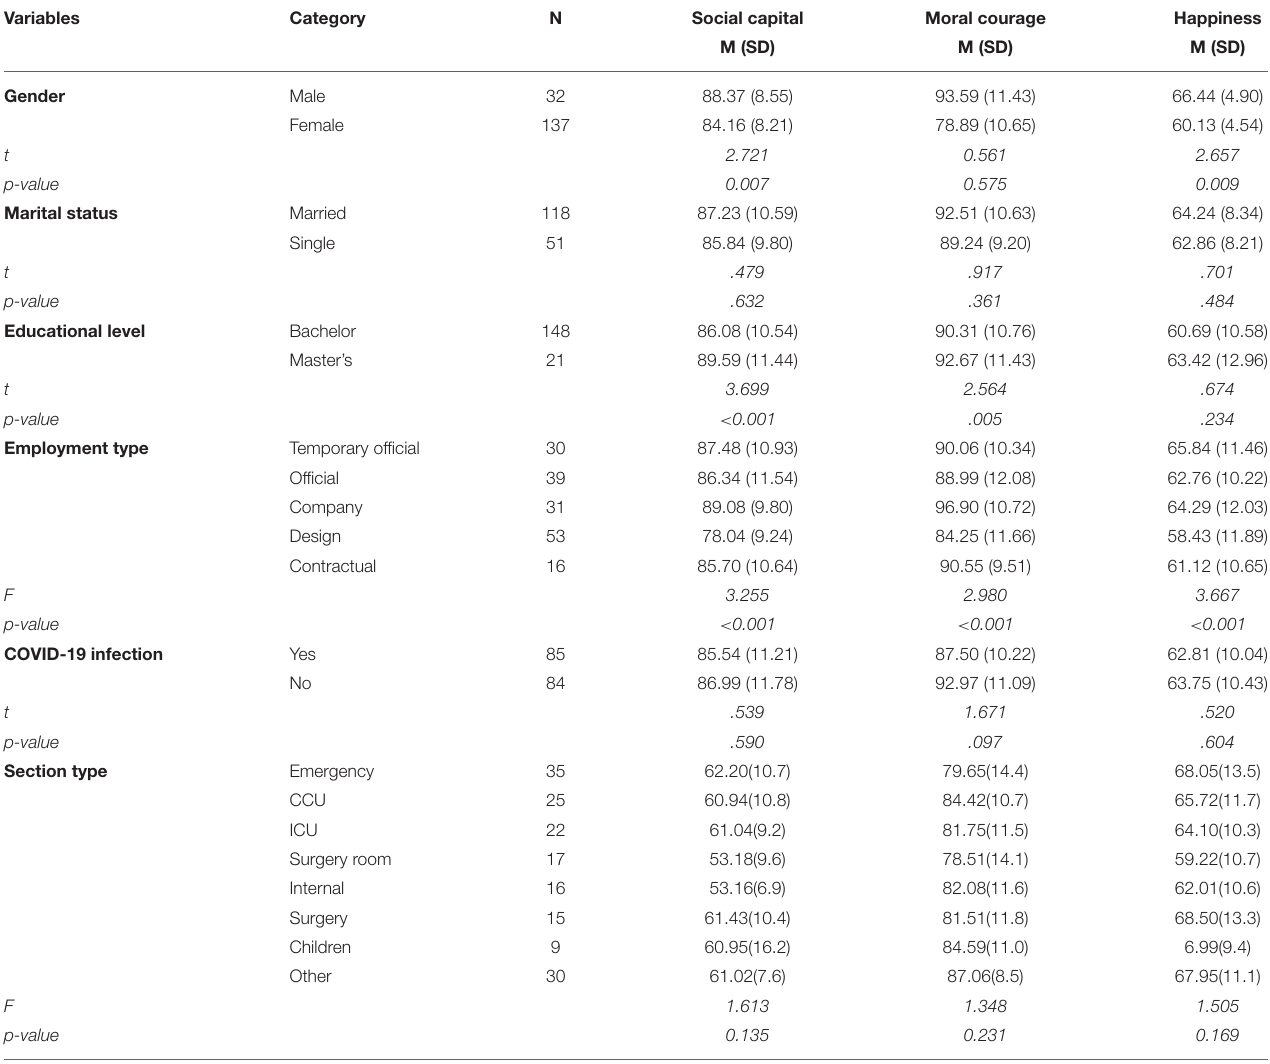
TABLE 2 | Mean Comparisons of Social Capital, Moral Courage, and Happiness.